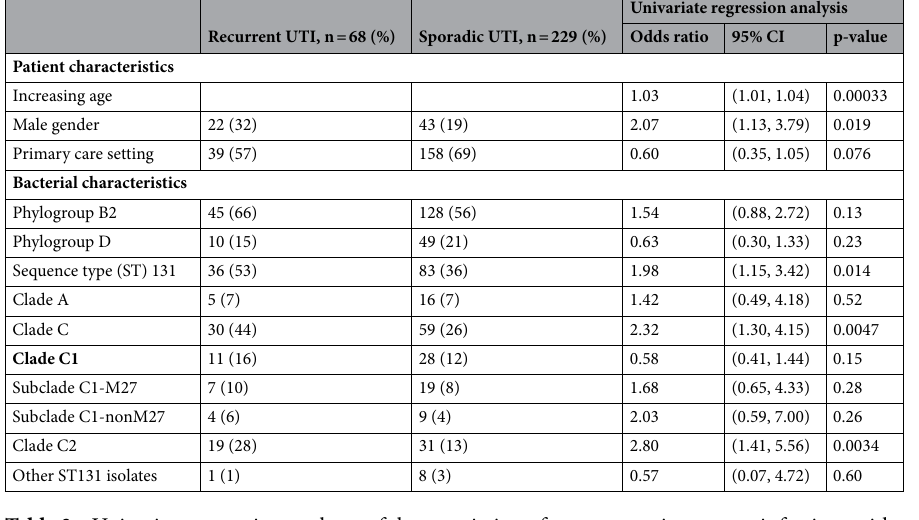
Table 3. Univariate regression analyses of the association of recurrent urinary tract infections with patient and bacterial characteristics in 297 patients with ESBL- E. coli urinary tract infection (UTI).